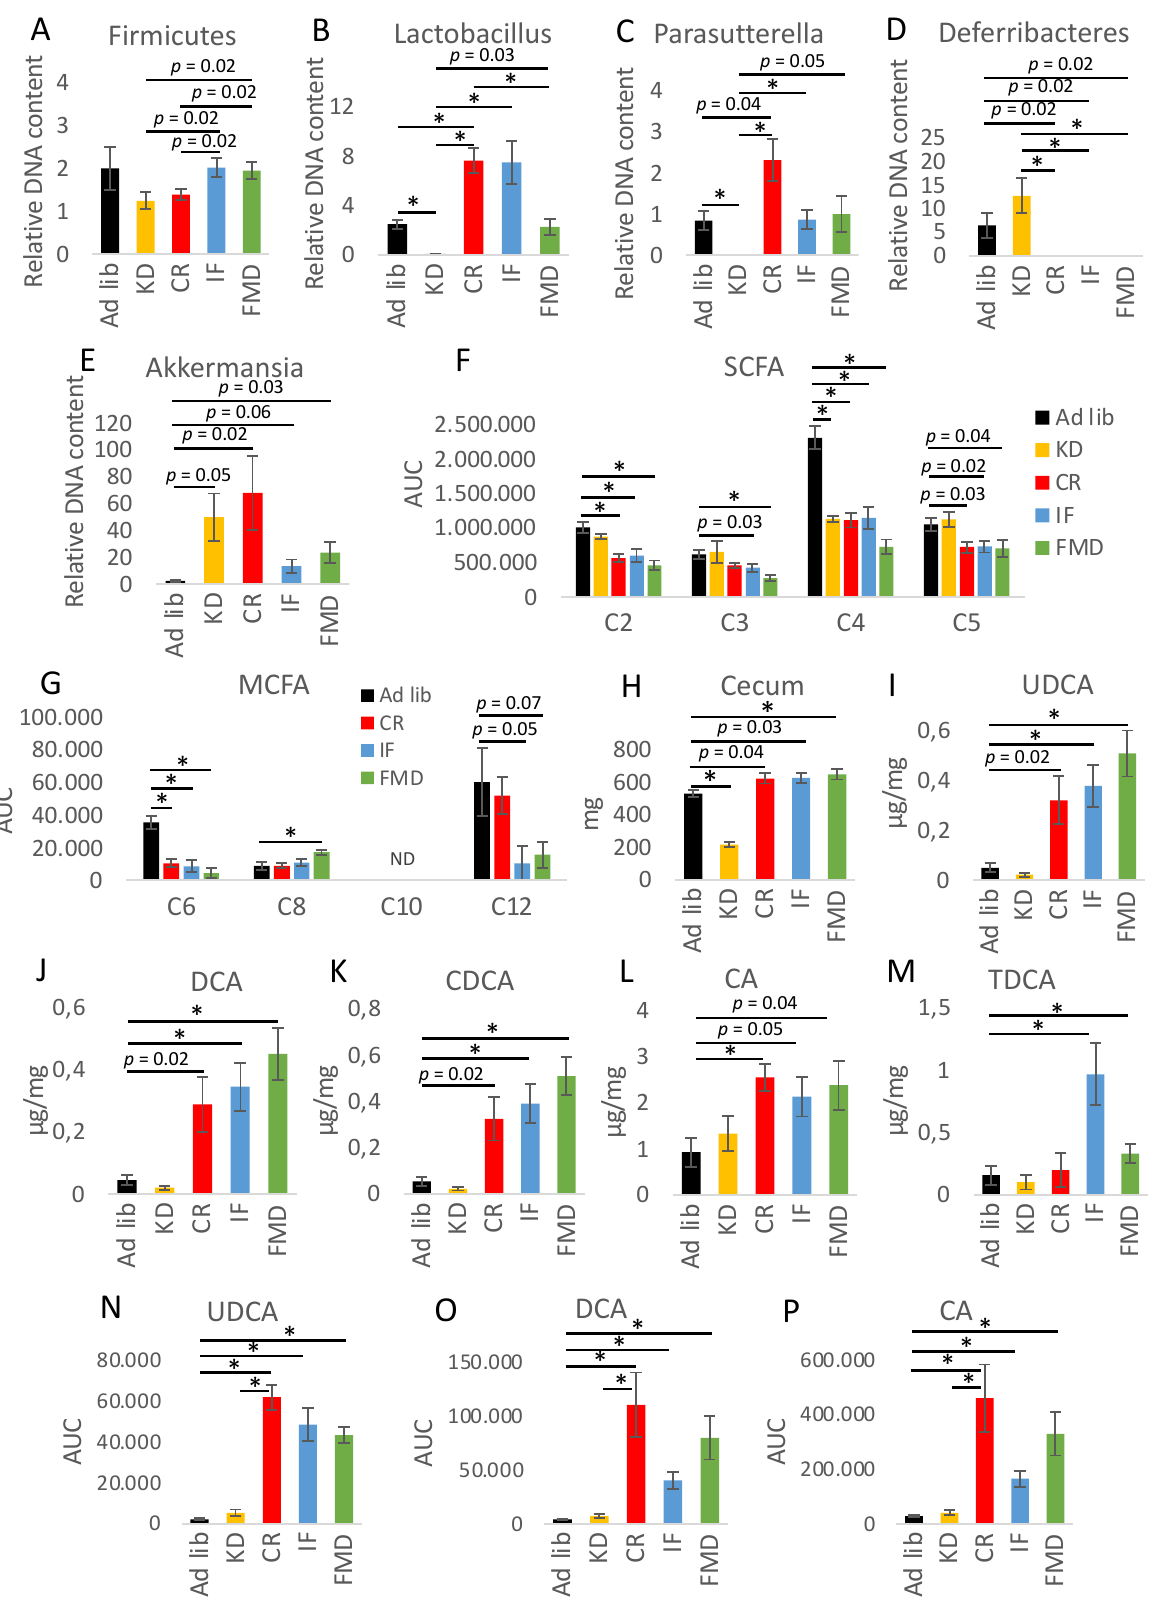
Figure 3. Restrictive diets modulate microbiota composition, the levels of microbiota-related factors, and metabolites. The relative abundance of Firmicutes ( A ), Lactobacillus ( B ), Parasutterella ( C ),